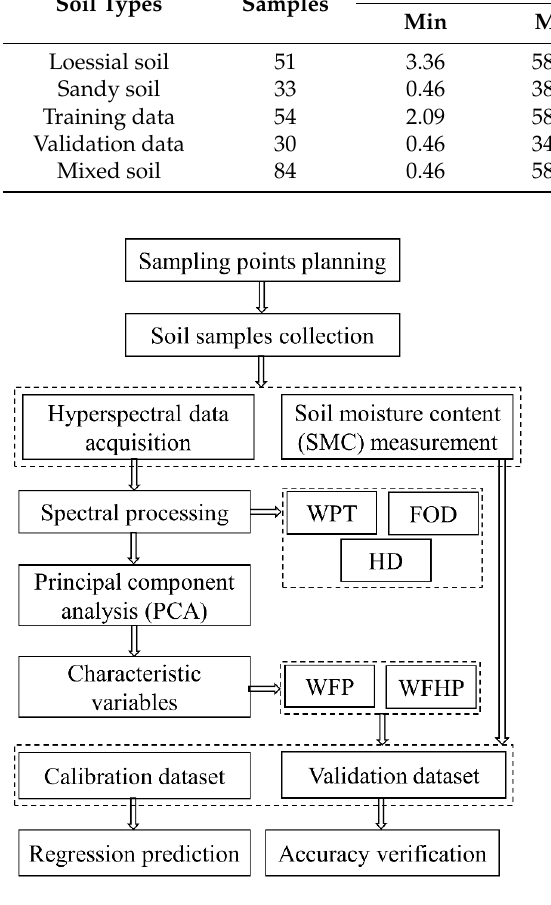
Figure 3. Flowchart indicating experimental methodology (WPT: wavelet packet transform; FOD: first-order differential; HD: harmonic decomposition; WFP: WPT-FOD-PCA; WFHP: WPT-FOD-HD-PCA). Table 2. Descriptive statistics of SMC in soils.